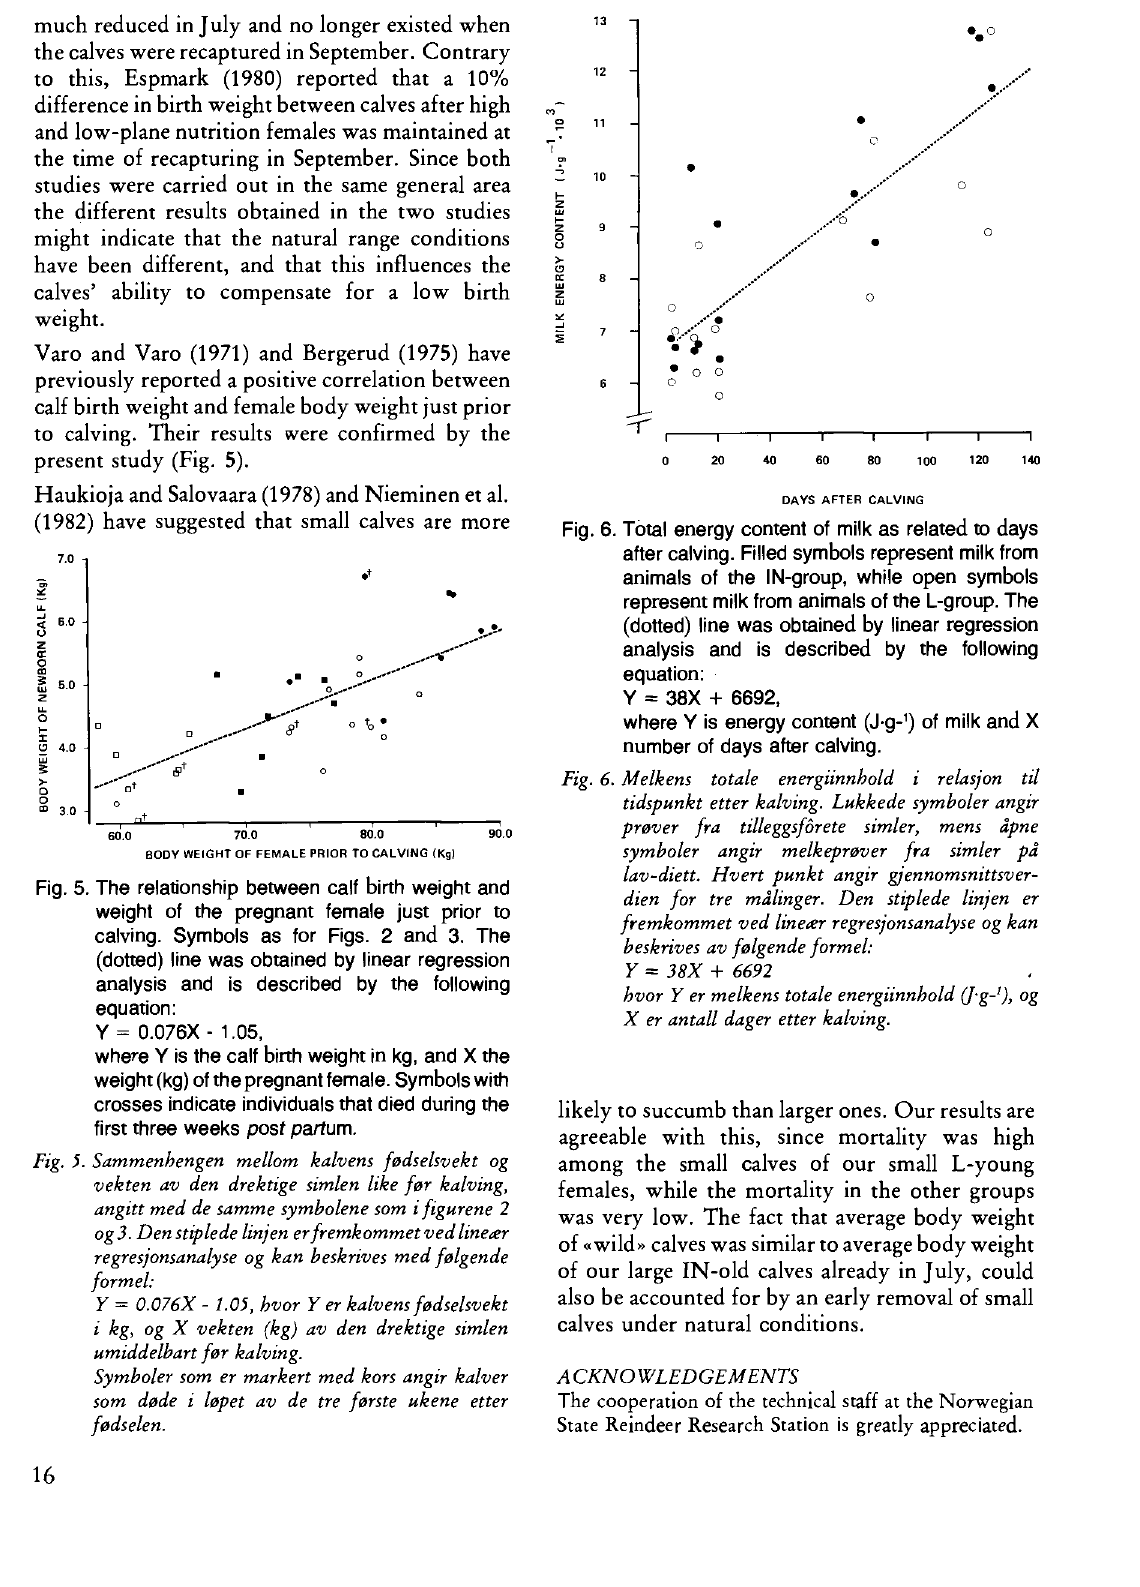
Fig. 5. The relationship between calf birth weight and weight of the pregnant female just prior to calving. Symbols as for Figs. 2 and 3. The (dotted) line was obtained by linear regression analysis and is described by the following equation: Y = 0.076X - 1.05, where Y is the calf birth weight in kg, and X the weight (kg) of the pregnant female. Symbols with crosses indicate individuals that died during the first three weeks post partum. Fig. 5. Sammenhengen mellom kalvens fødselsvekt og vekten av den drektige simlen like før kalving, angitt med de samme symbolene som i figurene 2 og 3. Den stiplede linjen er fremkommet ved linear regresjonsanalyse og kan beskrives med følgende formel: Y = Q.076X - 1.05, hvor Y er kalvens fødselsvekt i kg, og X vekten (kg) av den drektige simlen umiddelbart før kalving. Symboler som er markert med kors angir kalver som døde i løpet av de tre første ukene etter fødselen.